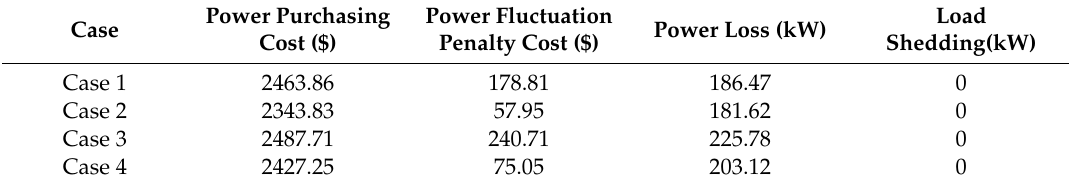
Table 6. Simulation results for di ff erent cases.